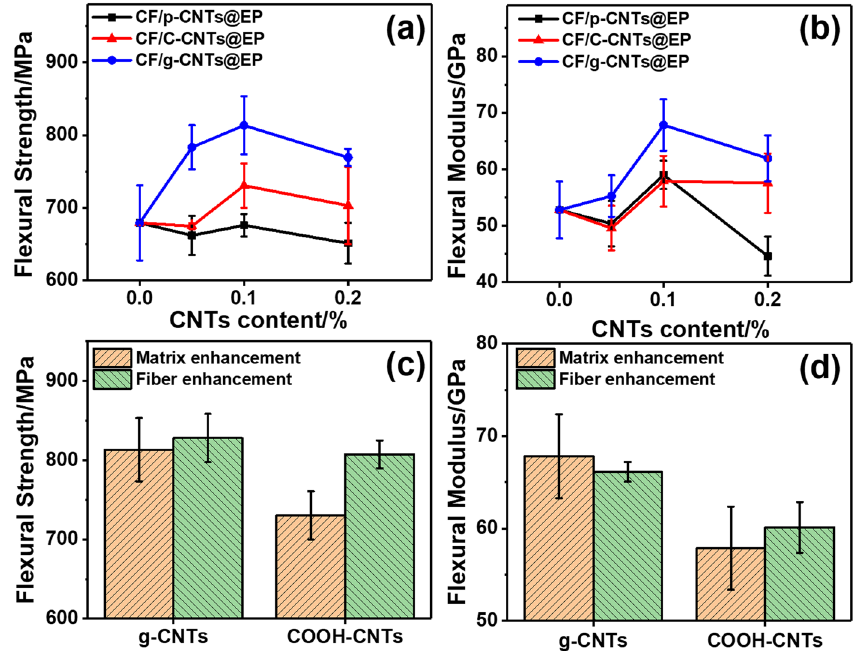
Figure 6: Flexural strength ( a ) and modulus ( b ) of CFRP enhanced by di ff erent concentrations of CNTs; comparison of optimum fl exural strength ( c ) and modulus ( d ) of CFRP modi fi ed via the fi ber enhancement ( 0.1 mg/mL, 10 V/cm, and 2 min for g - CNTs and 1 min for C - CNTs ) and matrix enhancement ( 0.1 wt% )